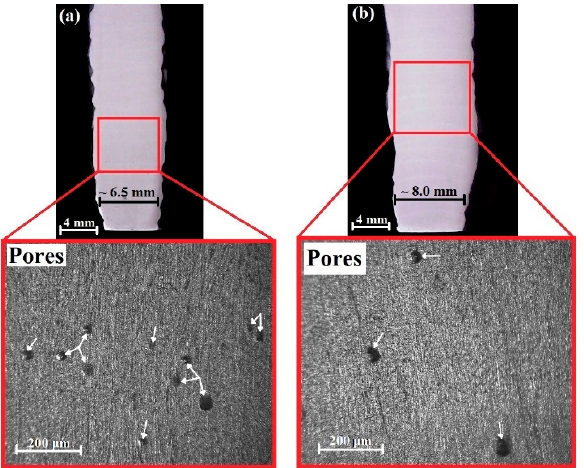
Figure 2. Optically detected pores in the cross sectional area of samples: ( a ) 20.0 mm/s, and ( b ) 13.3 mm/s, taken from the bottom position (B) of the specimens.